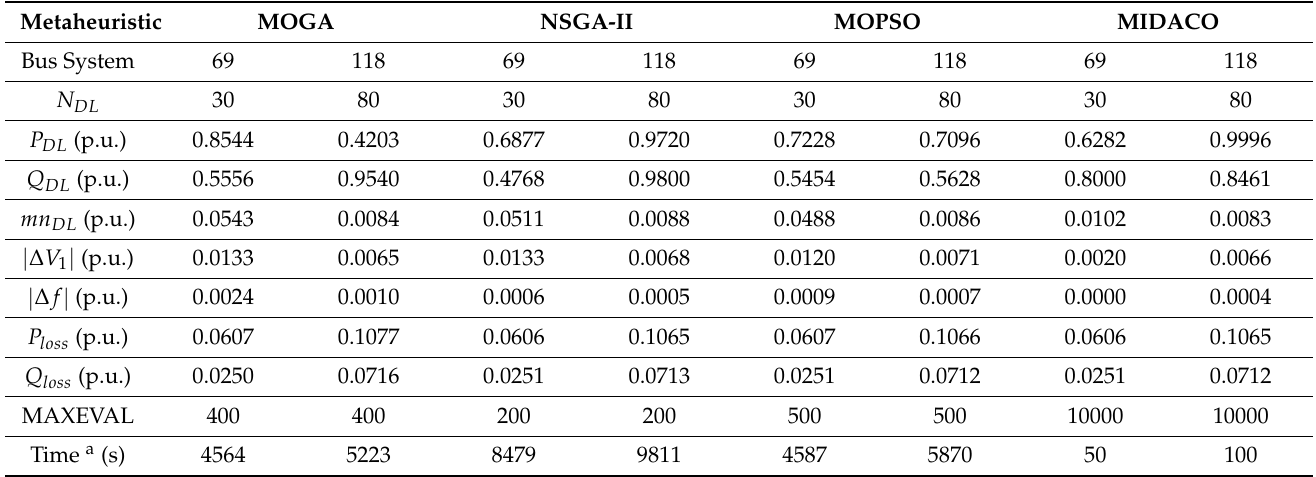
Table 11. Comparison of the multi-objective problem’s solution with other